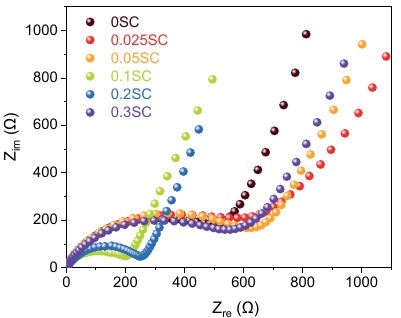
Figure 6. Nyquist plots of SnO 2 @CNTF obtained from EIS pattern.